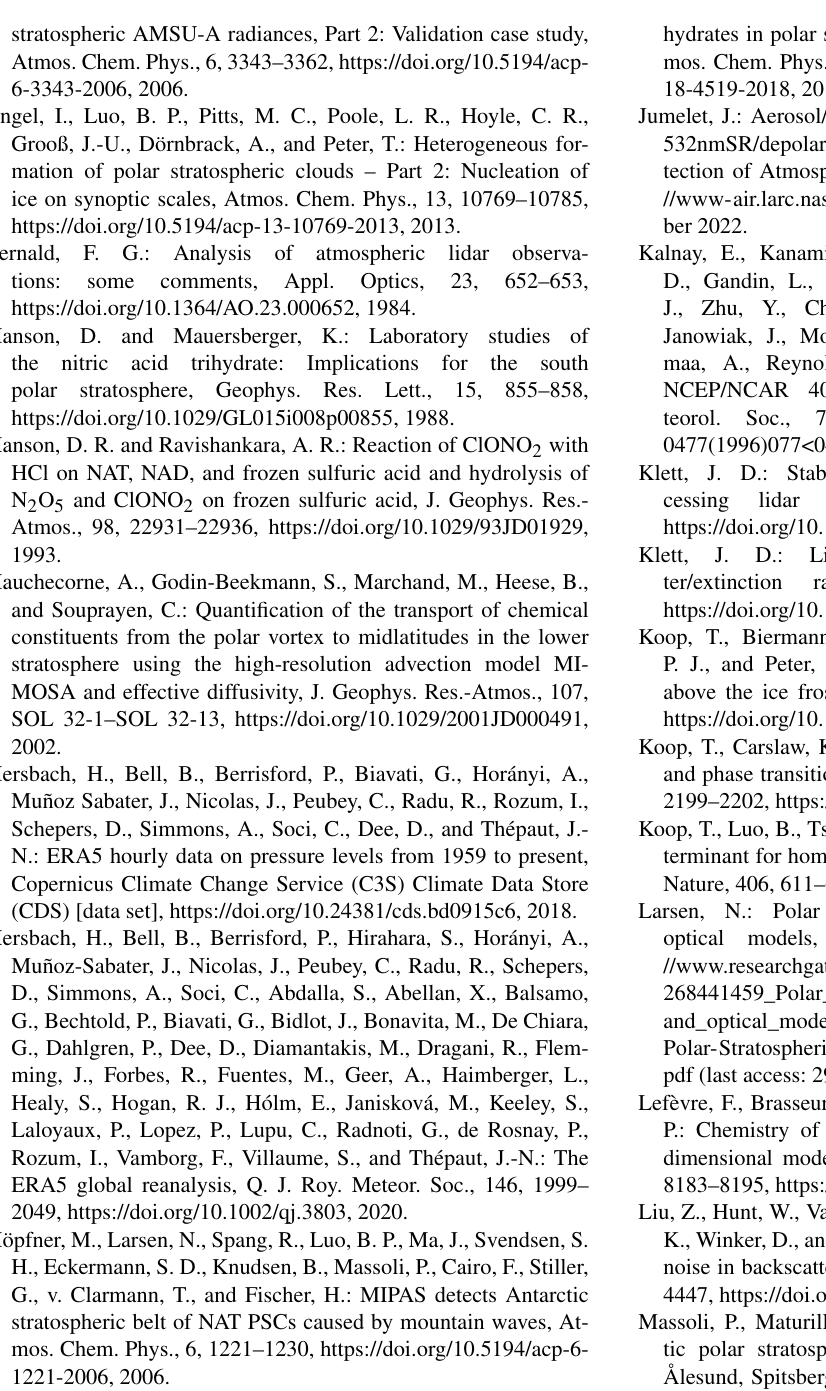
Algorithm Theoretical Basis Document – Part 1: